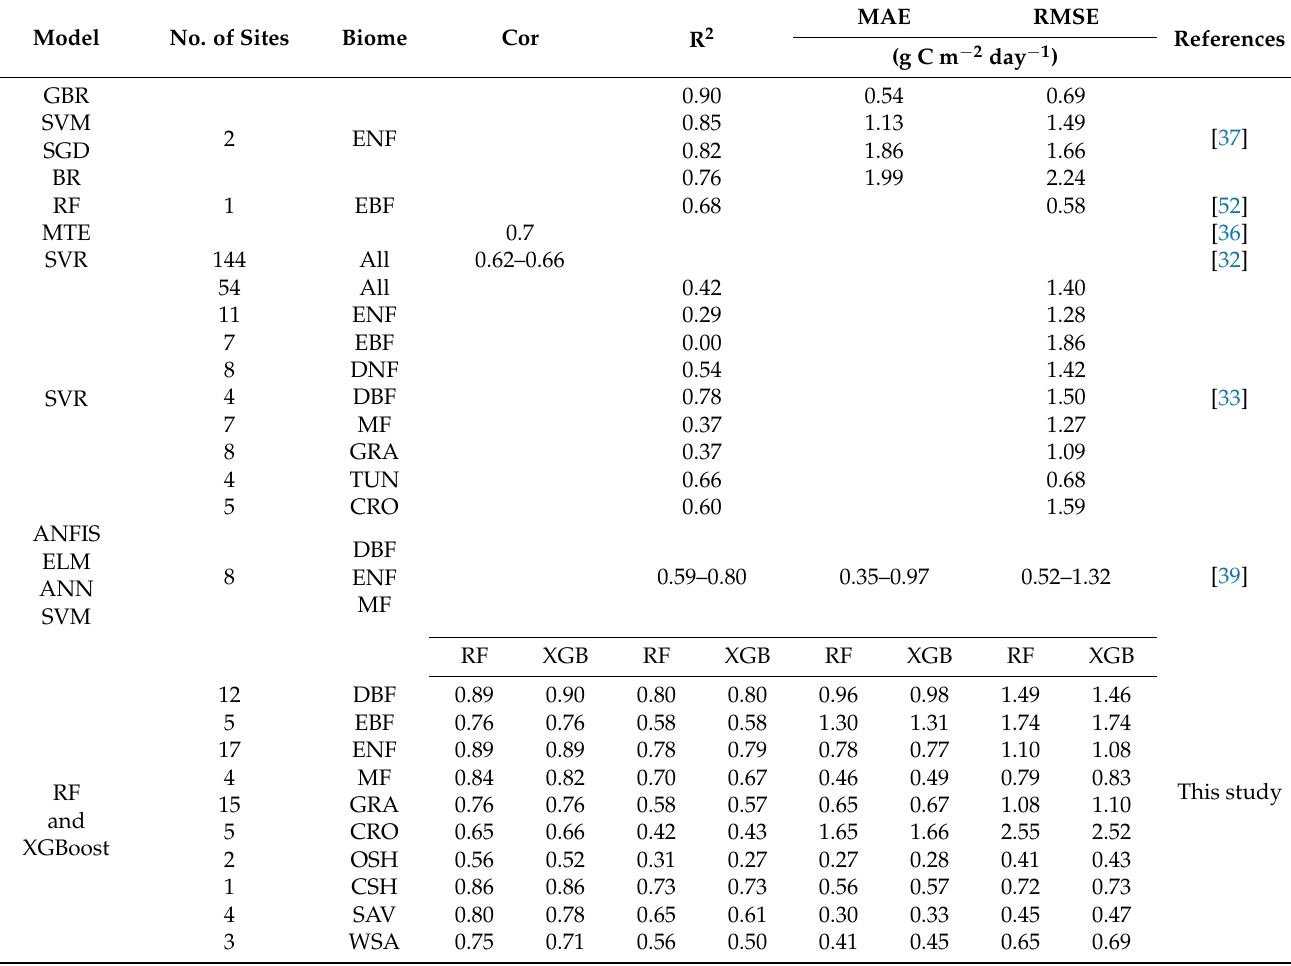
Table 5. Synthesis of NEE predicted by data-drive methods. List of acronyms: Cor, correlation coefficient; R 2 , determination; MAE, mean absolute error; RMSE, root mean square error; DBF, deciduous broadleaf forest; EBF, evergreen broadleaf forest; ENF, evergreen needleleaf forest; MF, mixed forest; GRA, grassland; CRO, cropland; OSH, open shrublands; CSH, closed shrublands; SAV, savannas; WSA, woody savannas; TUN, tundra; GBR, gradient boosting regression; SVM, support vector machine; SGD, stochastic gradient descent; BR, Bayesian ridge; RF, Random Forest; Model tree ensembles, MTE; SVR, support vector regression; SVR, support vector regression; ANFIS, adaptive neuro-fuzzy inference system; ELM, extreme learning machine; ANN, artificial neural network; SVM, support vector machine; XGBoost, Extreme Gradient Boosting.